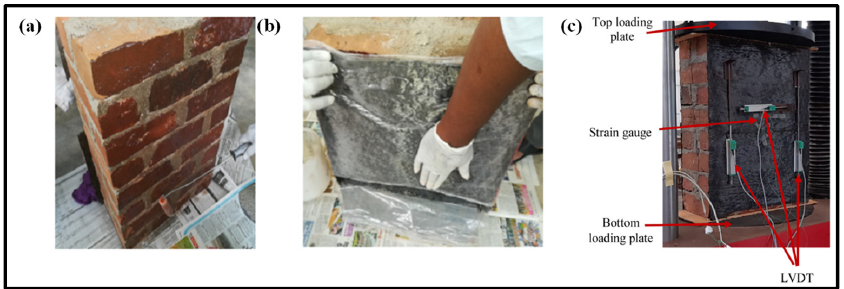
Figure 11. Preparation of CFRP-strengthened masonry wallettes; ( a ) bare masonry wallettes ( b ) CFRP layup using epoxy and ( c ) LVDTs attached on the surface of the CFRP fabric. The testing was carried out at a constant displacement rate of 0.25 mm/min using the same UTM of 1000 kN capacity to capture the complete post-crack behaviour of masonry wallettes under axial compression. The numerical model developed corresponding to the experimental test setup is shown in Figure 10. Displacement transducers were attached to the wallettes to capture the vertical deformation at mid-height of the wallettes, as shown